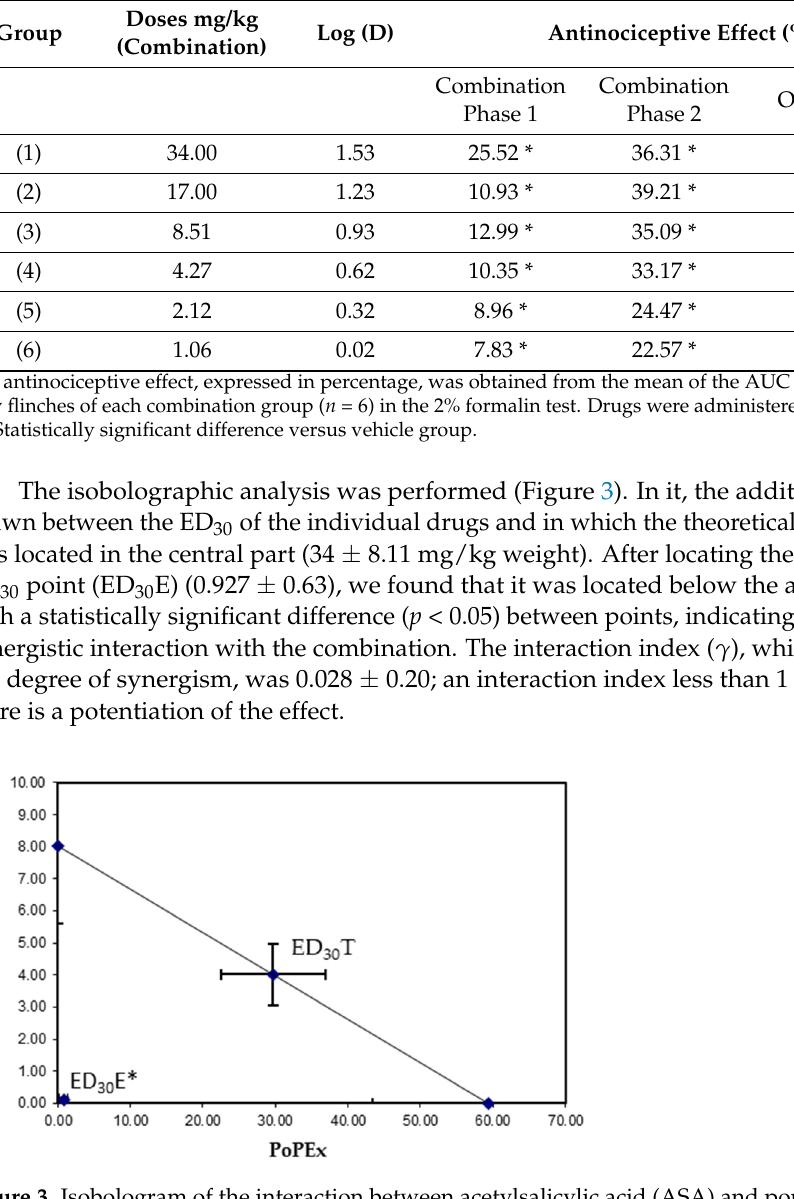
Table 2. Effect of the drug combination (PoPEx/ASA) in the formalin test.